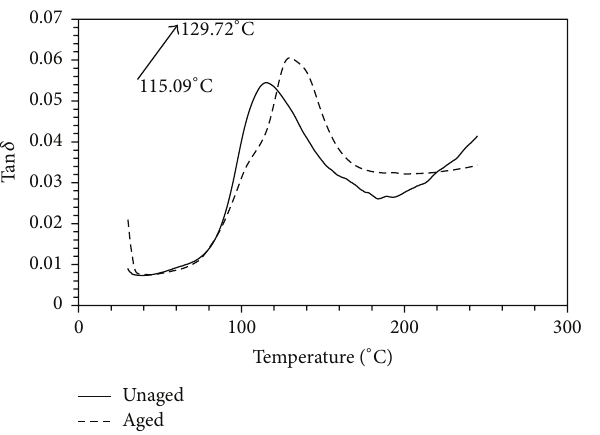
Figure 7: Changes in the onset temperature in EHG250-68-37 composite samples (initially and after 800 h thermooxidative aging in air at 82 ∘ C).